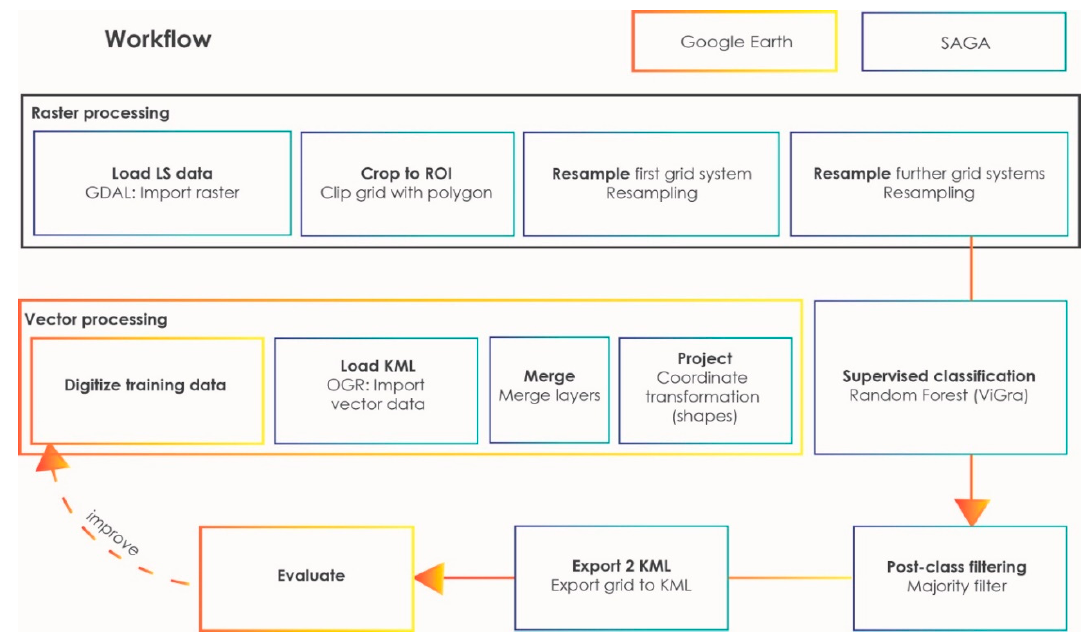
Figure 8. Flow-chart of the L0 level within the WUDAPT method, as presented by Bechtel et al. [102]. Source: Bechtel et al. [52,102].